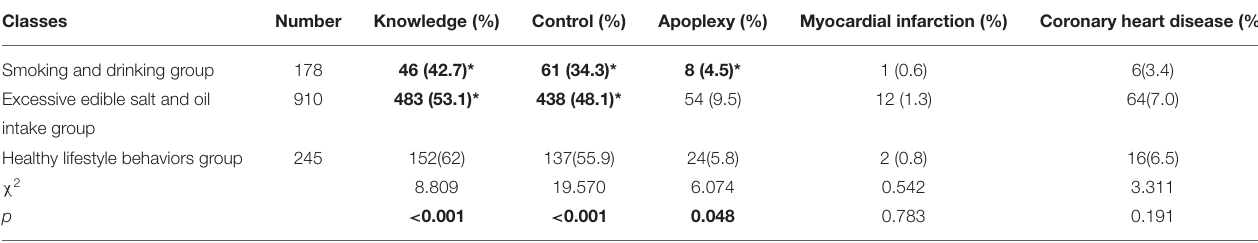
TABLE 3 | Comparison of three potential category classes.